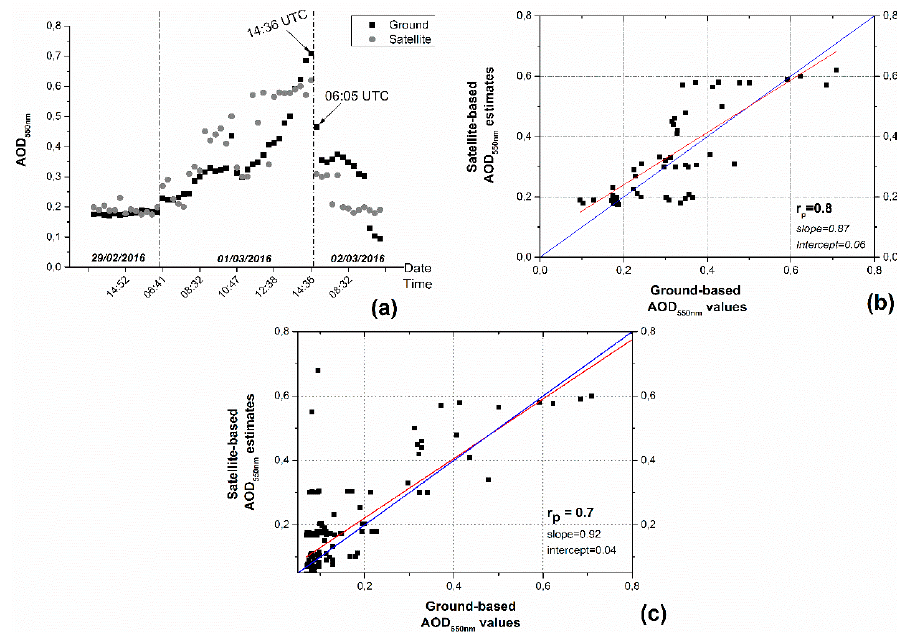
Figure 7. ( a ) Temporal evolution of the AOD 550 nm values (black dots) over the “FORTH_CRETE” AERONET station as retrieved by AERONET (black colored dots) and as derived by the ANN model (gray colored dots) during the period 29 February–2 March 2016. ( b ) Scatterplot comparison of the pairs of AERONET and ANN model AOD 550 nm values over the Crete-AERONET station during the period 29 February–1 March 2016. The red line corresponds to linear fit (slope = 0.87 and intercept = 0.06), while the blue line is the ideal (1:1) line. ( c ) Scatterplot comparison of the pairs of AERONET and ANN model AOD 550 nm data for the 14 AERONET stations for 1 March 2016. The red line corresponds to linear fit (slope = 0.92 and intercept = 0.04), while the blue line is the ideal (1:1) line.